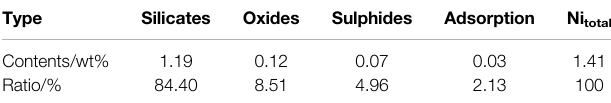
Table II. Measured and Theoretically Calculated Mass Losses as wel.